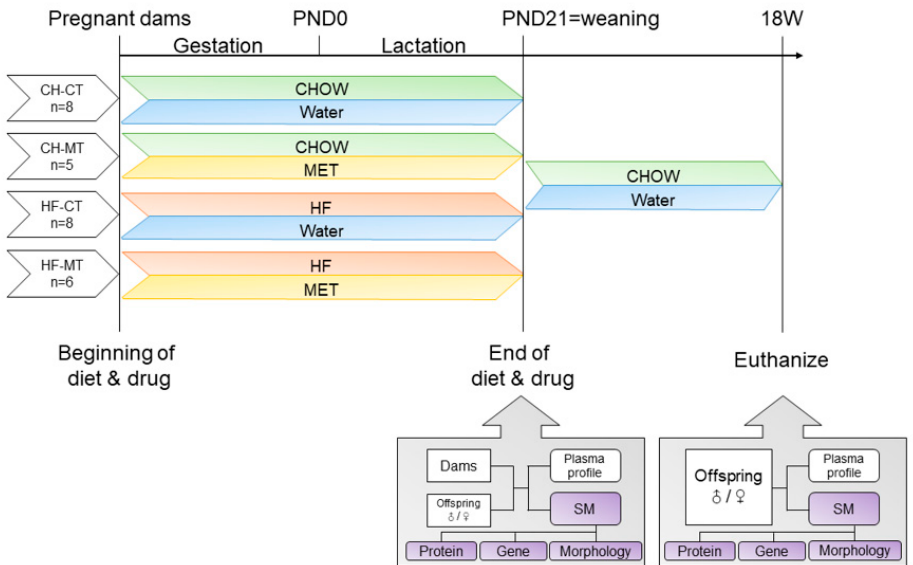
Figure 1. Schematic illustration of experimental groups. Dams were fed CHOW or high fat (HF) diet and given water with or without metformin (MET) throughout gestation and lactation. After weaning, offspring were all fed CHOW diet and given water without metformin. Plasma and skeletal muscle (SM) samples were collected on postnatal day (PND) 21 and at 18 weeks separately.